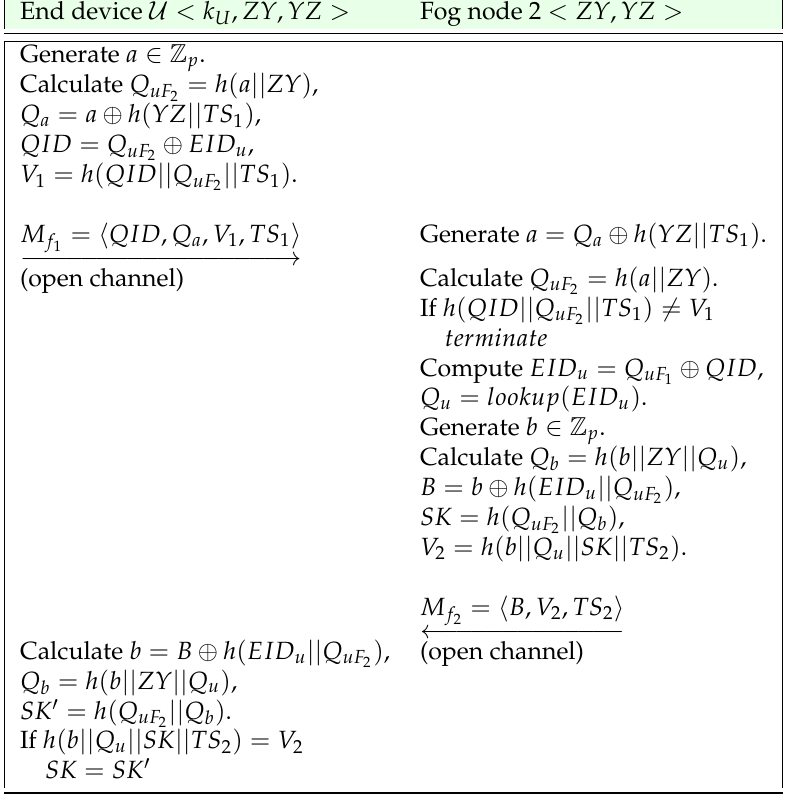
Figure 5. Summary of fast